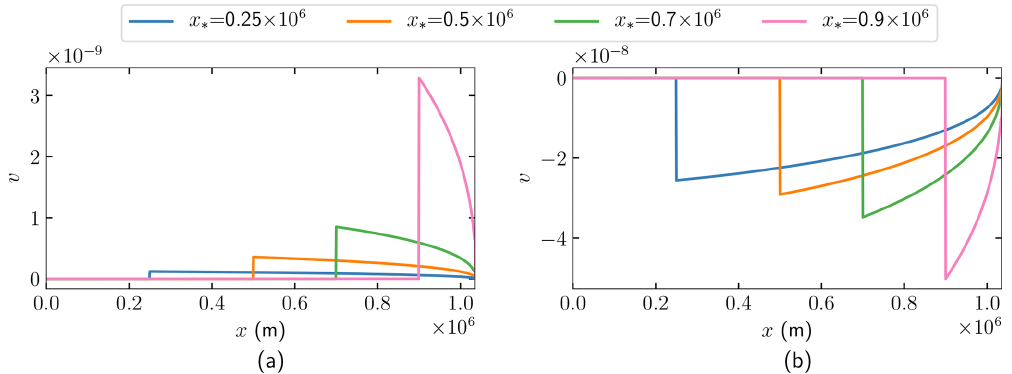
Figure 5. The analytical solutions of v in (40) of the observations of (a) u and (b) h at different locations x ∗ = 0 . 25 × 10 6 , 0 . 5 × 10 6 , 0 . 7 × 10 6 , and 0 . 9 × 10 6